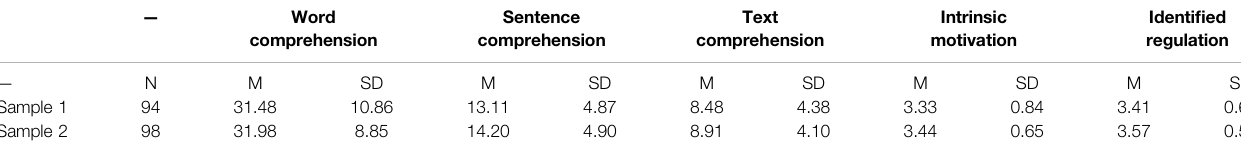
TABLE 3 | Means and standard deviations of the dependent variables at t2 by sample.